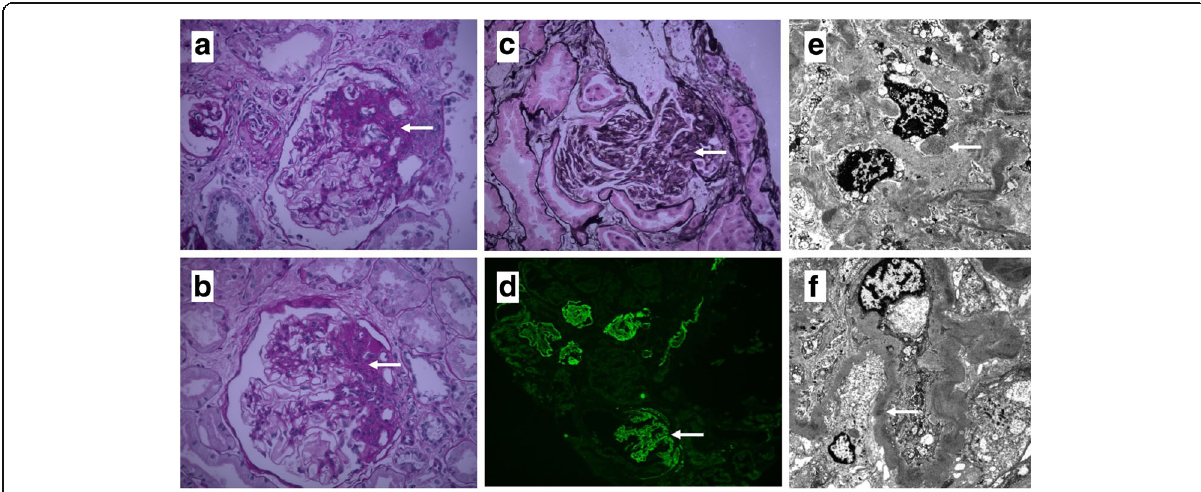
Fig. 2 Renal biopsy in a patient with CBS. Photomicrograph of renal biopsy specimen with HE, PAS ( a, b ) stain showed mesangial cell and matrix proliferation and PASM stain ( c ) showed focal segmental glomerulosclerosis. The immunofluorescence examination showed Immunoglobulins (IgM +, IgA +/ − ) and complements (C3 +/ − ) deposited in the mesangium and capillary wall ( d ). Electron microscopy showed focal segmental glomerulosclerosis with glomerular basement membrane thickened, immune complex deposits in mesangial matrix, vacuolar degeneration of tubular epithelial cells, renal interstitial fibrosis and inflammatory cells infiltration appears ( e , f ). (Arrows show the specific features.) ( a , b , c and d 40× magnification; e , f 4000×